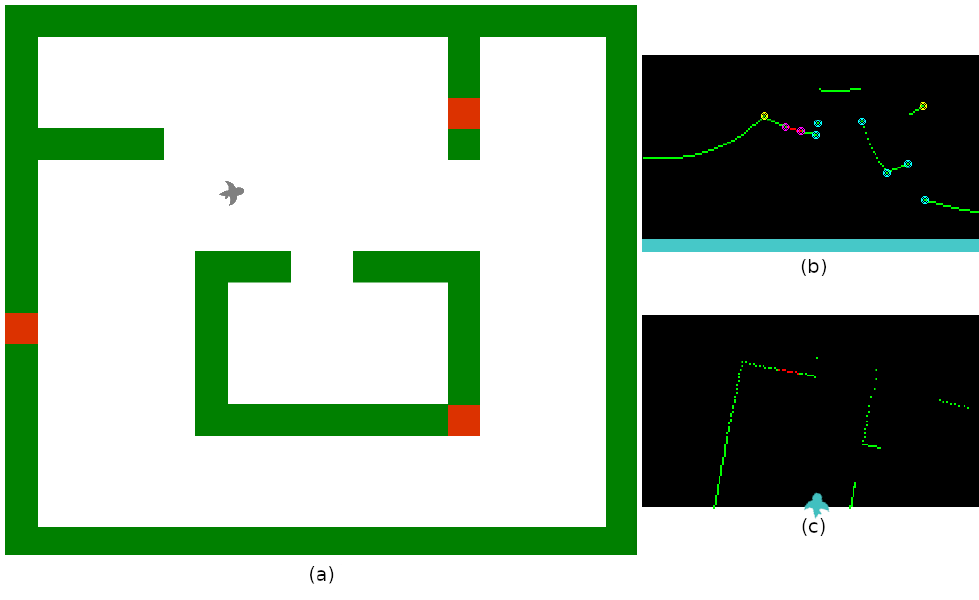
Figure 8. Experimental environment used: ( a ) the test environment is populated with green blocks and several red blocks to help discriminate similar places. ( b ) the agent’s 180 ◦ visual field (the agent can only use polar coordinates), which depth estimation precision decreases with distance. Inner corners, outer corners, and color changes are detected (respectively yellow, cyan and magenta circles). ( c ) the agent’s visual context is also given in a Cartesian reference frame (used to simplify grid cell module context computation). The agent is indicated in blue in figures ( b , c ), its field of view is